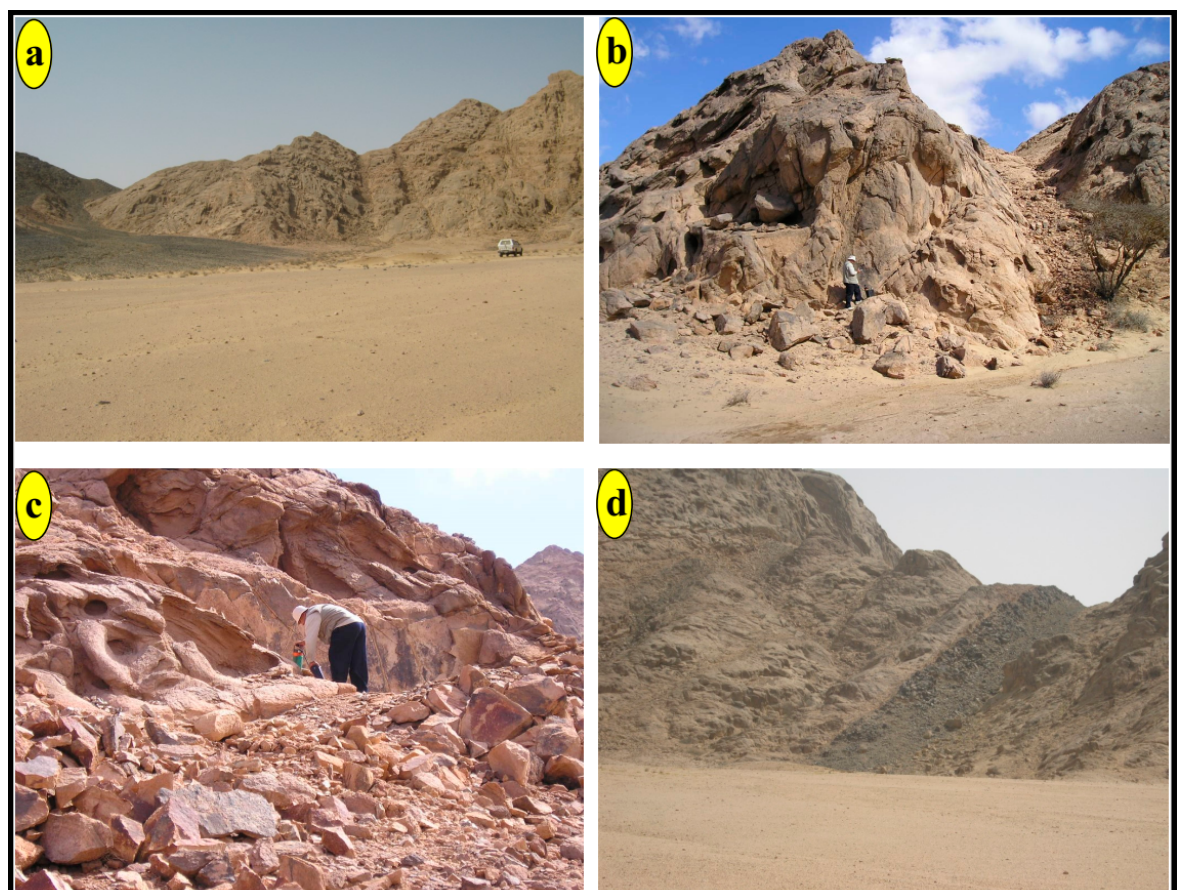
Figure 3. Field photographs of the studied area; ( a ) Sharp intrusive contact among muscovite and metavolcanic granite (SW), ( b , c ) Exfoliation, cavernous, and bouldery weathering in biotite and muscovite granite (W, E), and ( d ) Dark-black color basic dyke cut in the western part of the muscovite granite (E).